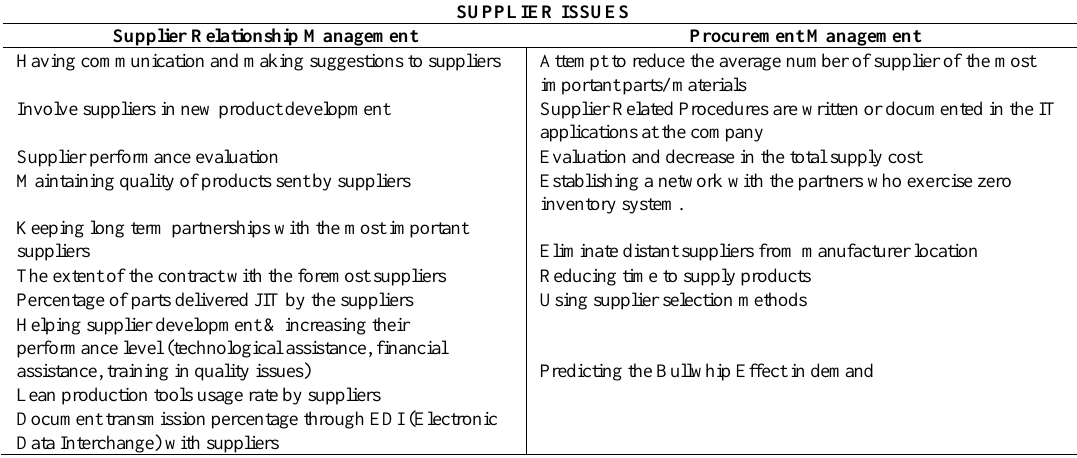
Table 3. Sub-criteria and measures for the supplier issues main criterion SUPPLIER ISSUES Supplier Relationship